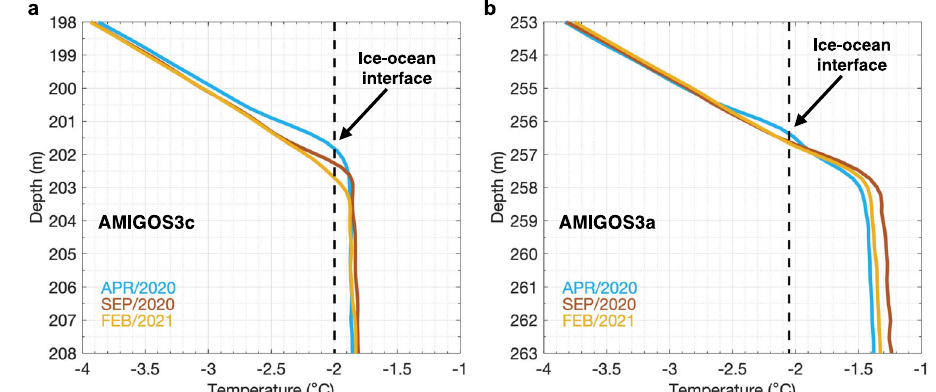
Fig. 3 | Monthly averaged in situ temperature pro fi les beneath Thwaites East- ern Ice Shelf (TEIS) measured by fi bre-optic cables. a In situ temperature recorded at AMIGOS3c for April 2020 (light blue), September 2020 (red), and February 2021 (orange). b Same as a , but for AMIGOS3a. The vertical dashed